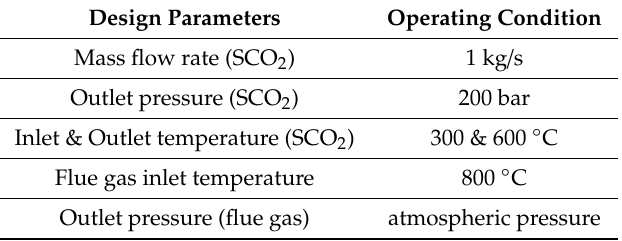
Table 1. Operating condition of the SCO 2 heat